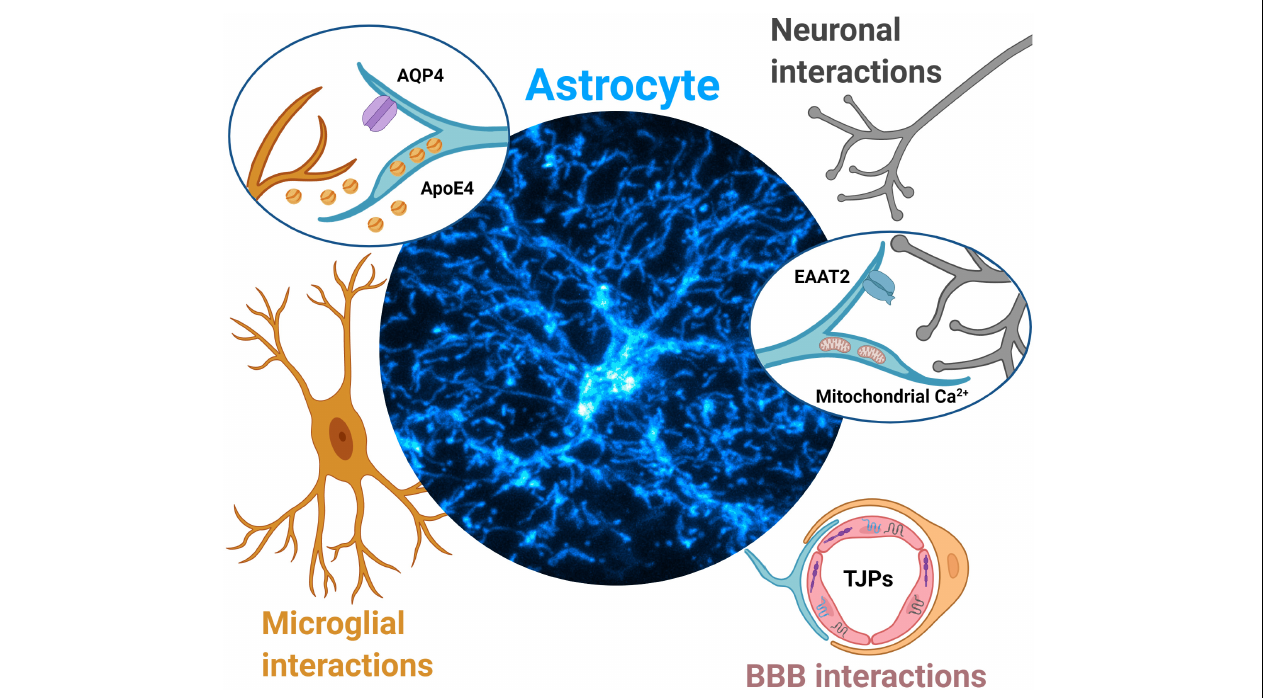
FIGURE 1 | Aberrant astrocytic Ca 2 + signals contribute to Parkinson’s disease pathology via multiple mechanisms. Neuronal interactions. Dopamine surges during early PD may dysregulate astrocytic Ca 2 + signals and lead to EAAT2 internalization, leading to reduced glutamate clearance and initiation of excitotoxic cell death for dopaminergic midbrain neurons. Disruptions in astrocytic mitochondria Ca 2 + signals (triggered from protein aggregates such as α -synuclein) lead to reduced ATP production, alteration of mitochondria-ER tethering, likely contributing to dopaminergic neurodegeneration. Microglial interactions. Aberrant astrocytic Ca 2 + signals drive mislocalization of AQP4 channels in astrocytes. AQP4 deficiency in astrocytes is associated with increases in microglial activity and further secretion of inflammatory cytokines, ultimately contributing to dopaminergic neurodegeneration. Aberrant astrocytic Ca 2 + signals may drive increased secretion of ApoE4 which leads to microglial reactivity, increased α -synuclein pathology and eventually dopaminergic neurodegeneration. Blood brain barrier (BBB) interactions. Aberrant Ca 2 + signals in astrocyte endfeet may result in altered secretion of neurotrophic factors such as GDNF, leading to dysregulation of tight junction proteins (TJPs), compromised BBB integrity, and further contribute to dopaminergic